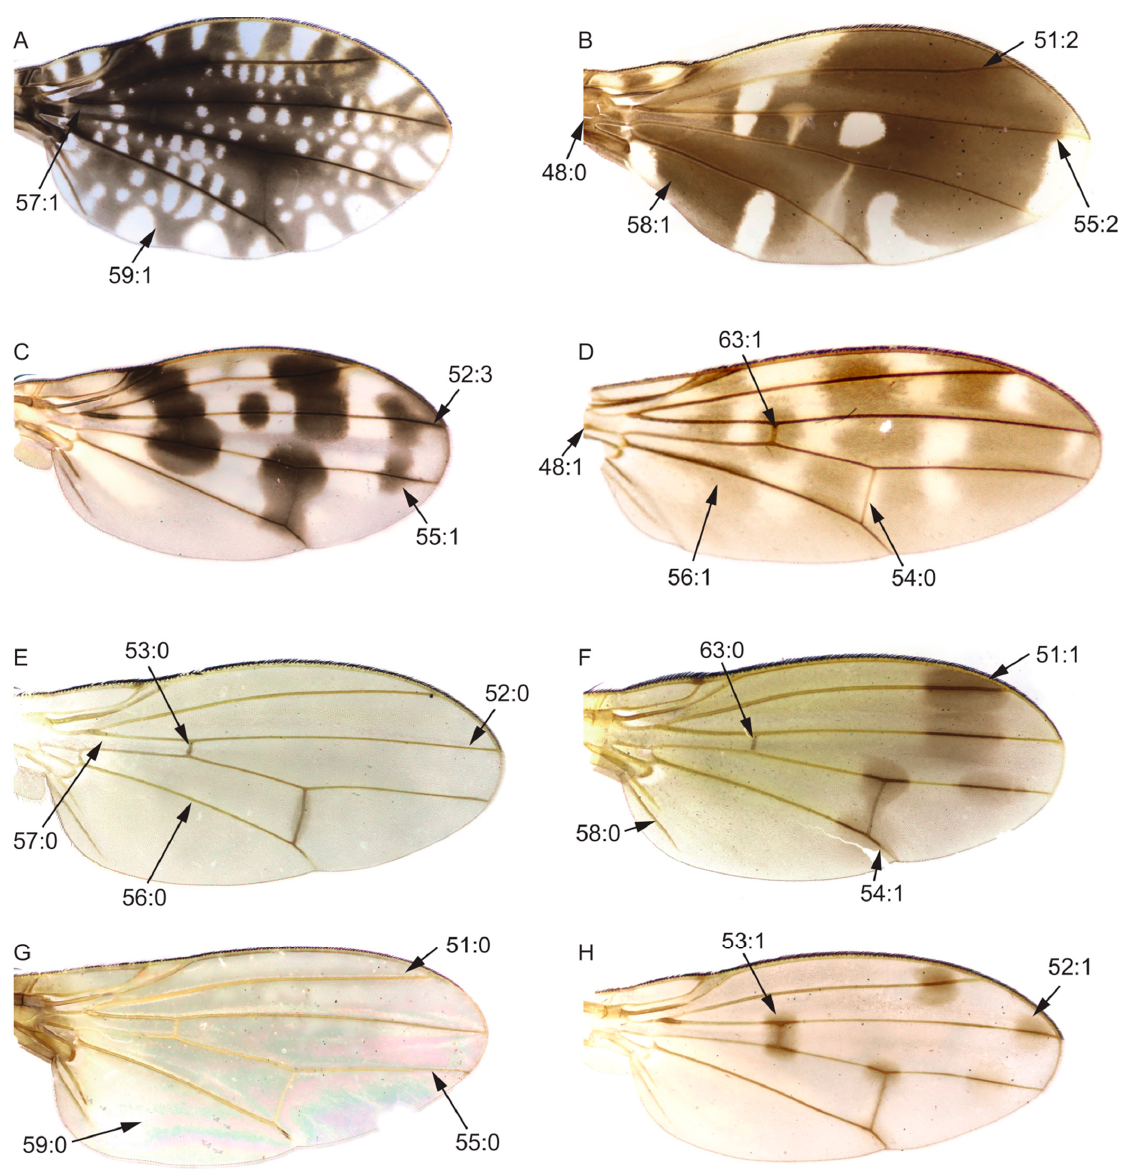
Figure 4. Wing characters. ( A ): Homoneura ( Homoneura ) picta ; ( B ): Noonamyia umbrellata ; ( C ): Homoneura ( Homoneura ) posterotricuspis ; ( D ): Prosopophorella yoshiyasui ; ( E ): Homoneura ( Homoneura ) flavida ; ( F ): Homoneura ( Neohomoneura ) zengae ; ( G ): Minettia ( Frendelia ) longipennis ; ( H ): Homoneura ( Euhomoneura ) yanqingensis Abdomen: 65. Color of tergites 3–6: (0) black; (1) brown or yellow. 66. Spot on middle of tergite 2: (0) absent (Figure 5B); (1) present (Figure 5A). 67. Spot on side of tergite 2: (0) absent (Figure 5E); (1) present (Figure 5D). 68. Spot on middle of tergite 5: (0) absent (Figure 5C); (1) present (Figure 5D). 69. Side of tergite 5: (0) without spot (Figure 5F); (1) with striped spot (Figure 5D); (2) with circular spot (Figure 5E).